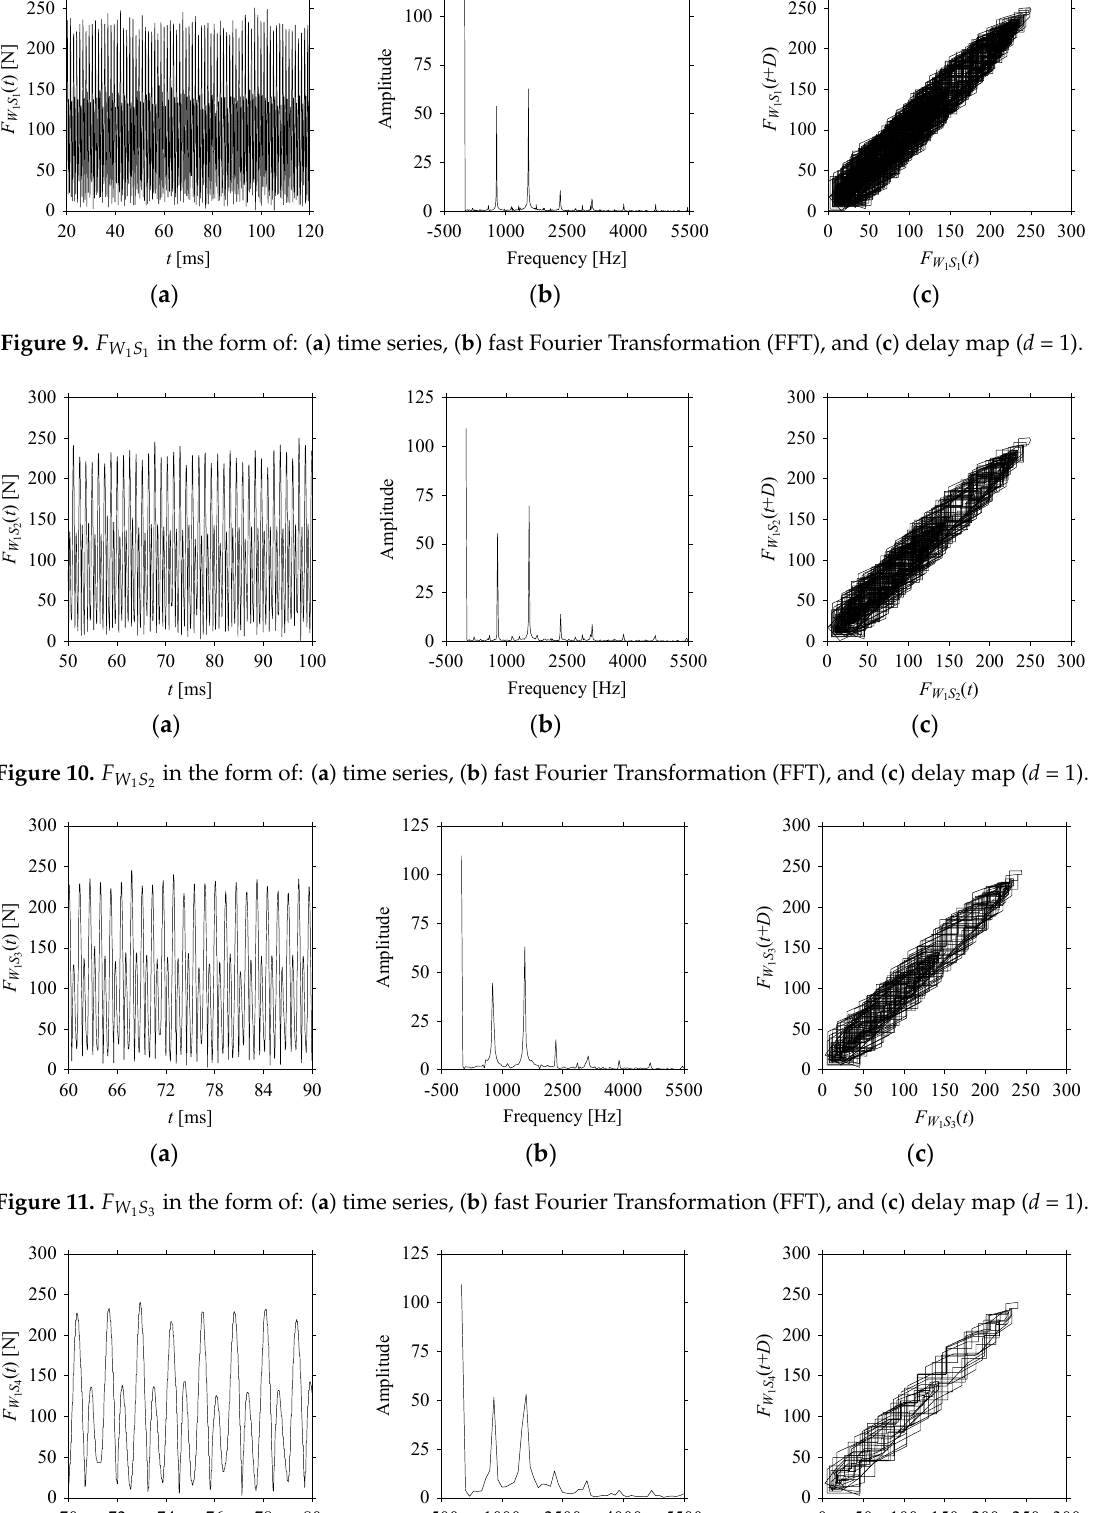
Figure 8. F W in the form of: ( a ) time series, ( b ) fast Fourier Transformation (FFT), and ( c ) delay map ( d = 1). 1